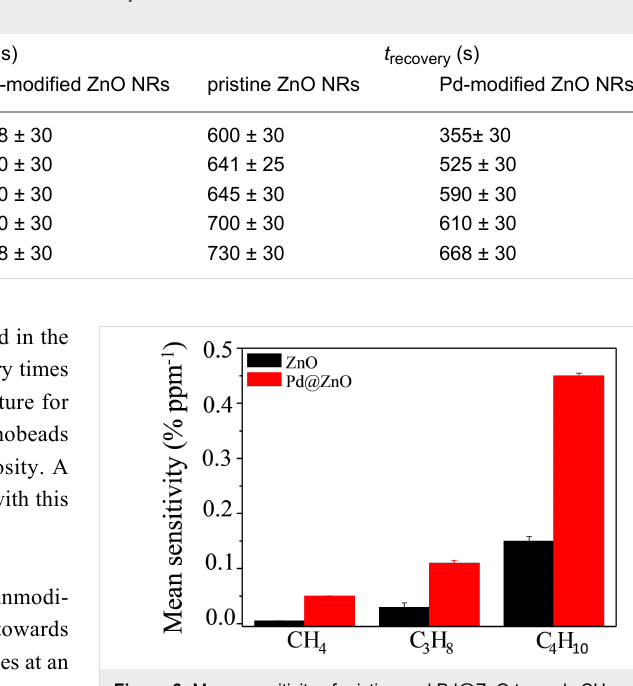
Figure 6: Mean sensitivity of pristine and Pd@ZnO towards CH 4 , C 3 H 8 , and C 4 H 10 gases at an operating temperature of 300